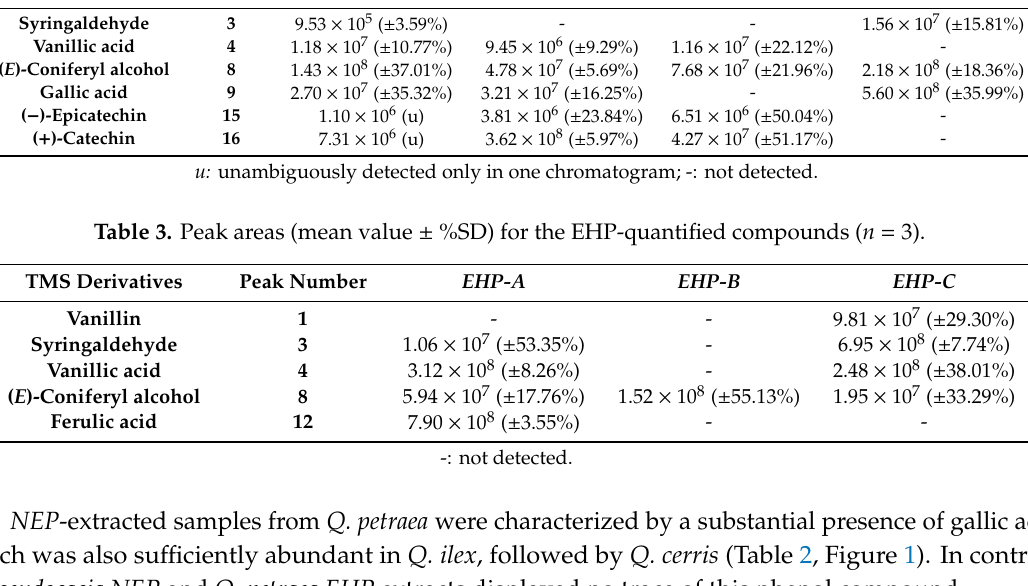
Table 2. Peak areas (mean value ± %SD) for the NEP -quantified compounds ( n = 3). TMS Derivatives R. pseudoacacia